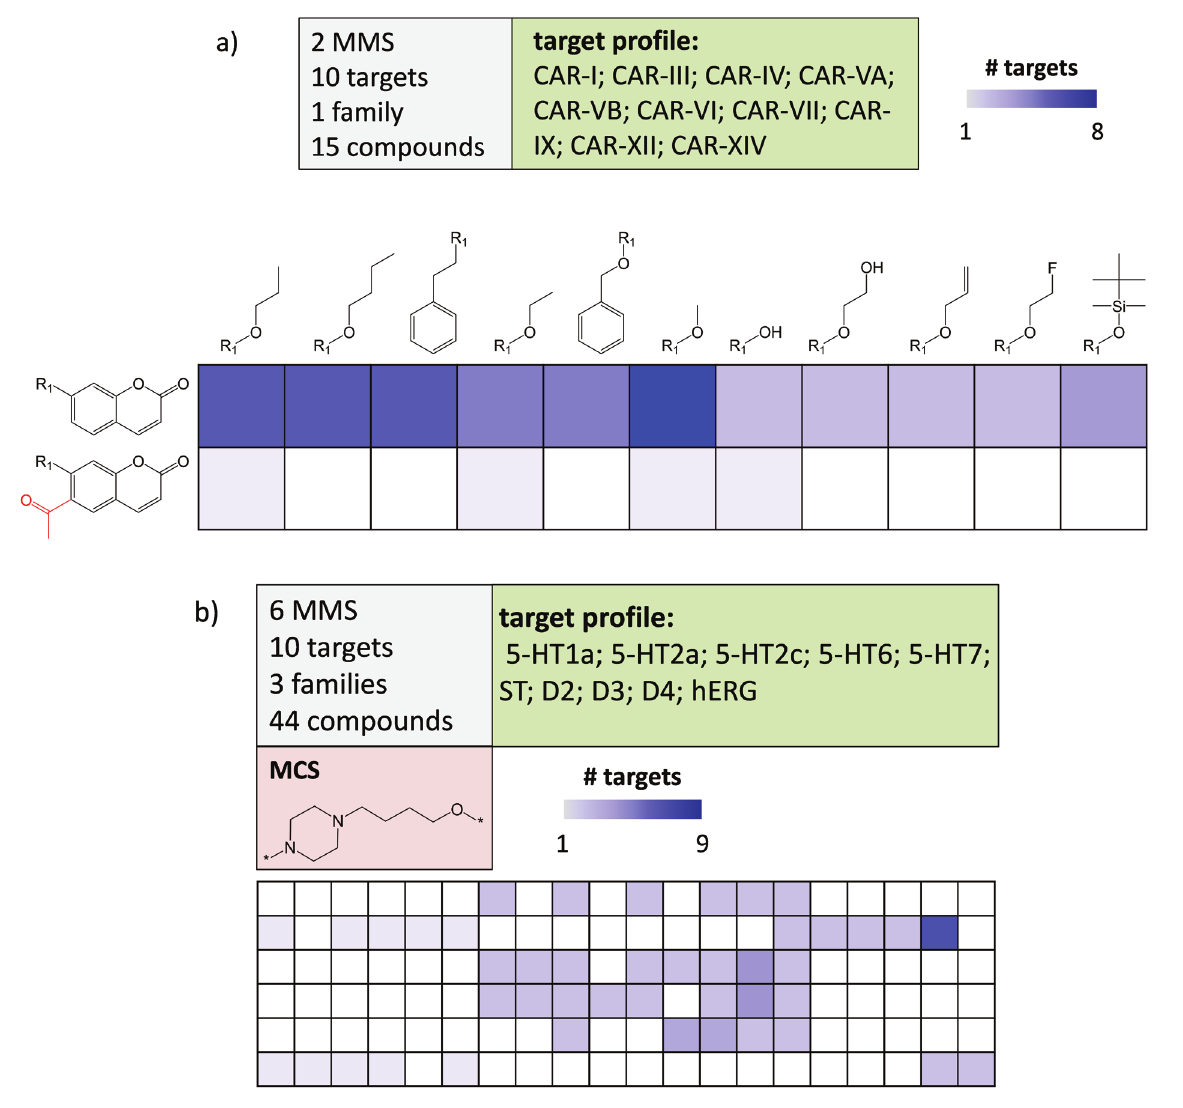
Figure 7. Multi-target compound series matrices. ( a ) shows a CSM containing 15 inhibitors of 10 carbonic anhydrase (CAR) isoforms. Target coverage of analogs is reflected by increasingly dark blue shading of cells. Substructures distinguishing the core fragments are highlighted in red. The matrix composition is summarized (top left) and the target profile reported (top right). ( b ) shows a CSM with 44 analogs active against 10 targets (including the hERG anti-target) belonging to three different families. The maximum common core structure (MCS) of the analog series is displayed. For clarity, compound structures are omitted. Target abbreviations: 5-HT; serotonin receptor, ST; serotonin transporter, D; dopamine receptor, hERG; hERG ion